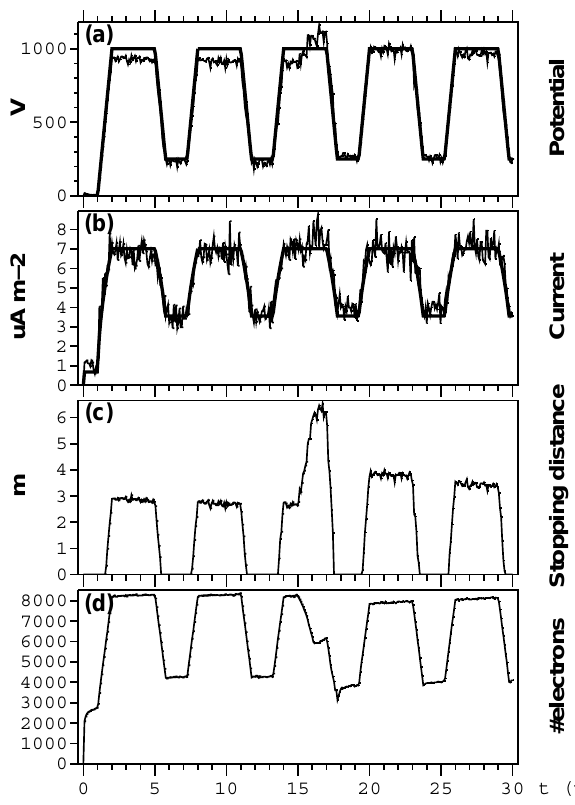
Fig. 10. Results of 1-D simulation with periodic voltage input and artificial electron heating period included at 14.9–16.1ms. Driver and actual potential (a) , model (Eq. 9) and actual current density on wire (b) , proton stopping distance r s of formed potential structure (c) , number of electrons in simulation box (d) . In panels (a) and (b), piecewise linear thick line is analytic model and thin fluctuating curve is actual simulation